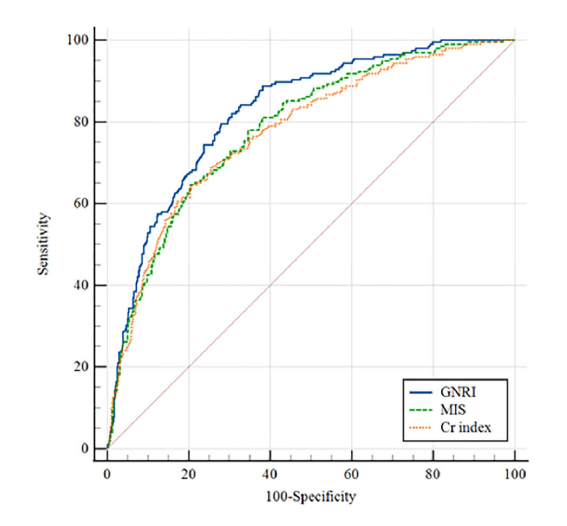
FIGURE2 Receiver operating characteristic (ROC) curve for geriatric nutritional risk index (GNRI), malnutrition inflammation score (MIS), and Creatinine (Cr) index according to